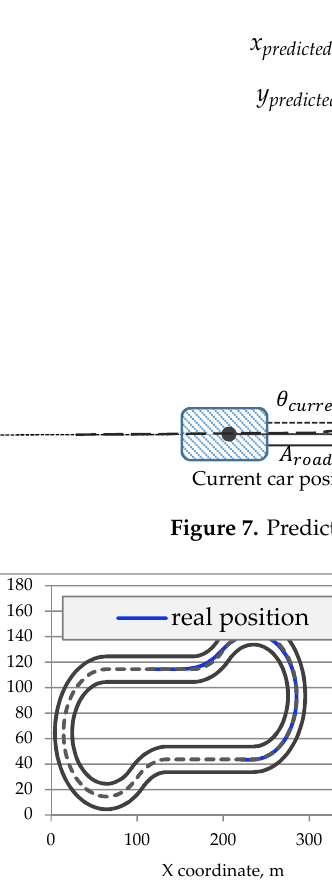
Figure 8. Real trajectory of the car ( a ) and predicted position of the car ( b ). Time of the prediction—1.5 s, (cid:2020) = 0.1.